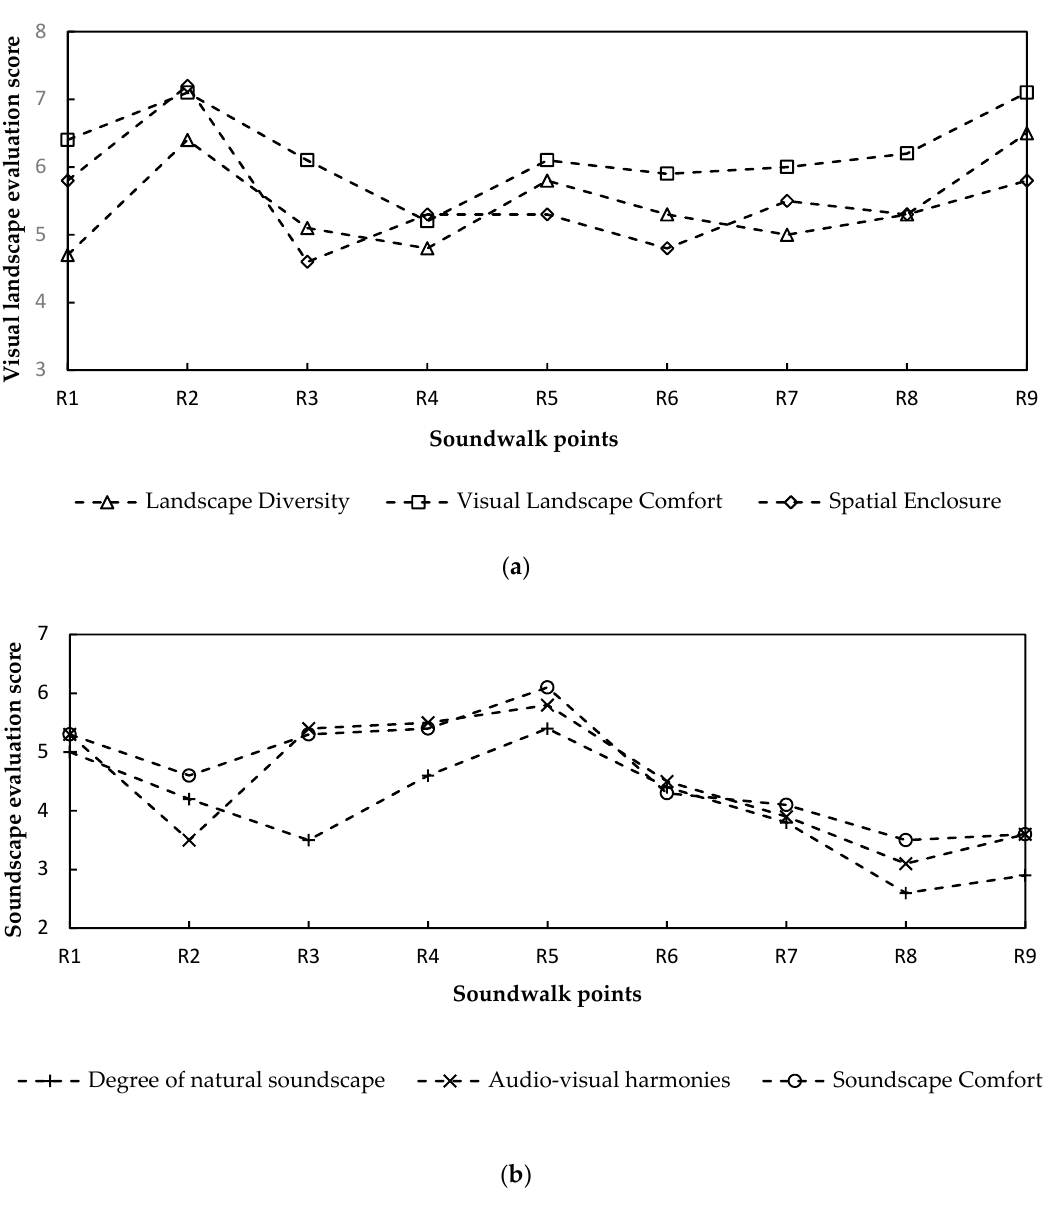
Figure 7. The score of soundscape evaluation at each soundwalk point: ( a ) visual landscape comfort evaluation and ( b ) soundscape comfort evaluation.